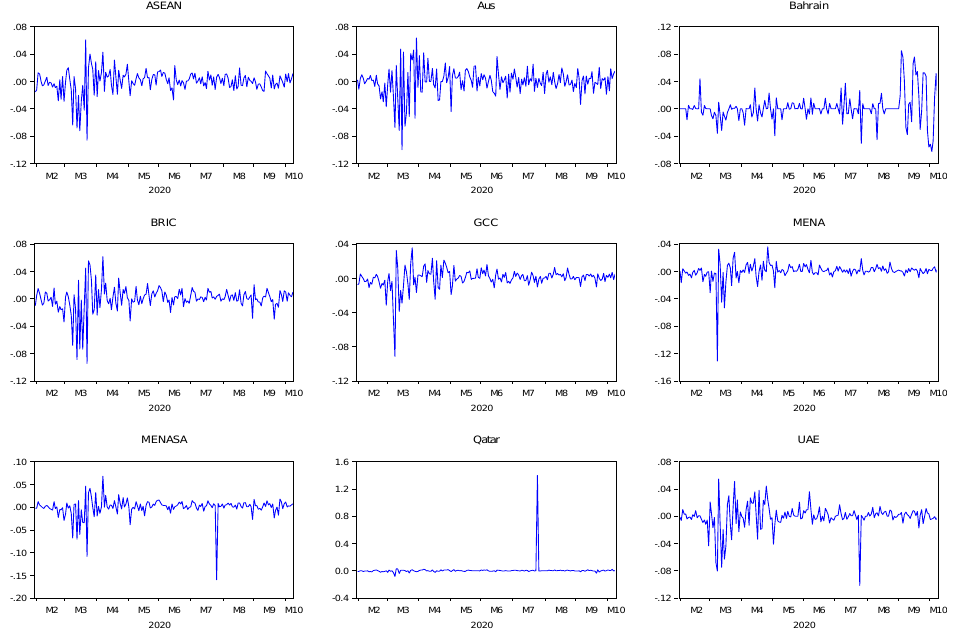
Figure A3. Pre-Crisis Period. Source: Authors’ calculation using EViews 10.